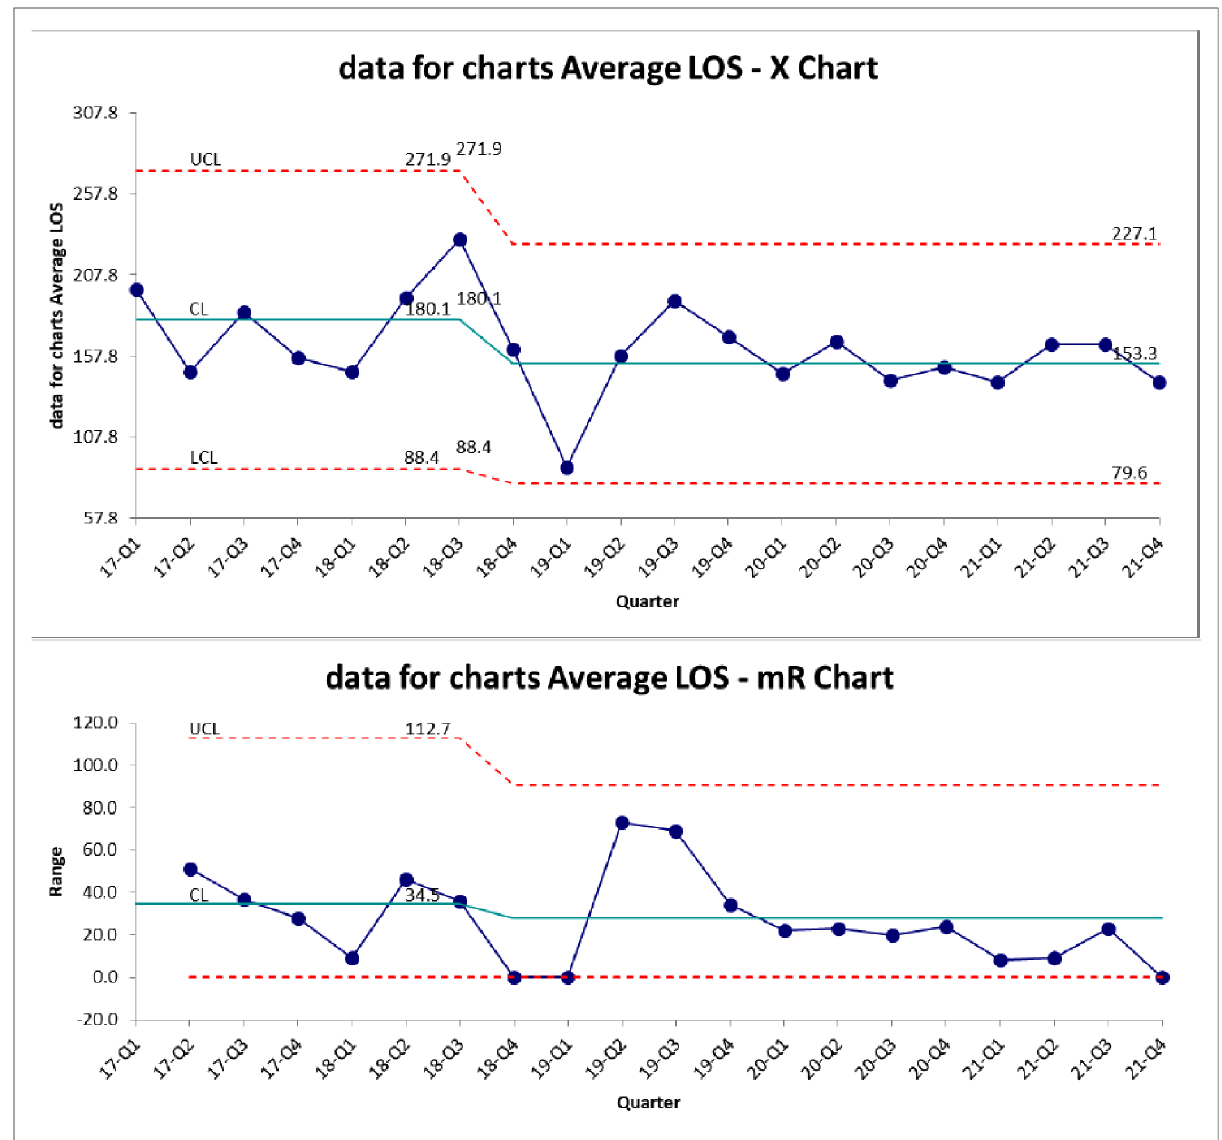
FIGURE 3 Average length of stay each quarter XmR chart.